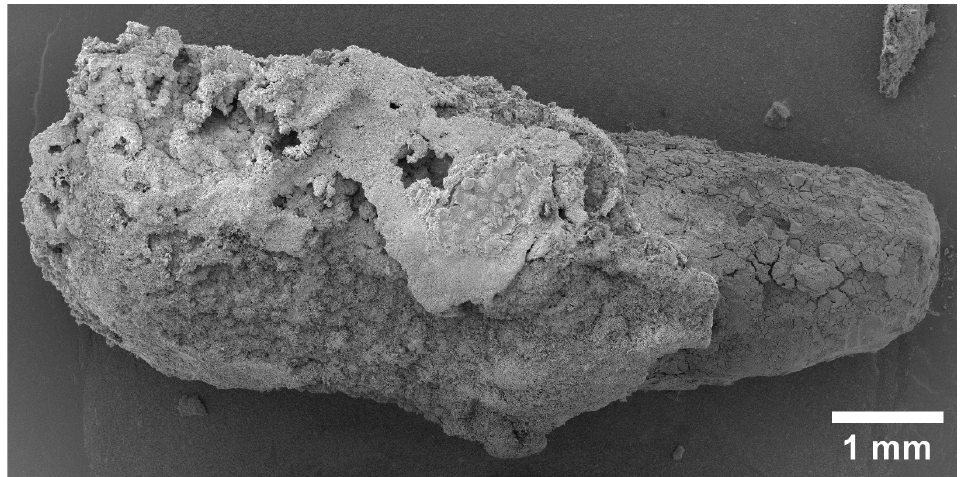
Figure 1. SEM image of magnesium implant surface obtained by reflection of secondary electrons 1 month after installation.